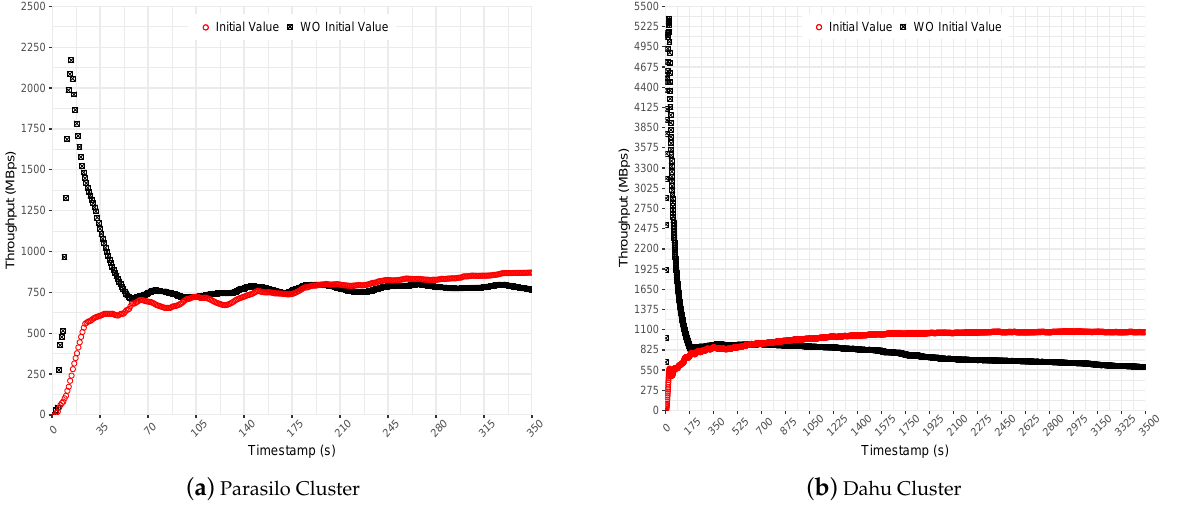
Figure 8. Backpressure Initial Rate Feature Comparison for Stateful SUMServer Application— Pipeline